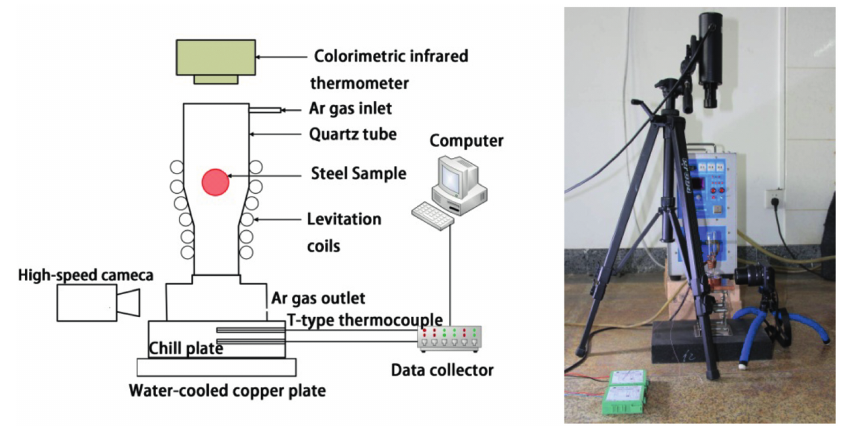
Figure 1: Schematic and whole assembly diagram of initial solidification experiment of steel droplet.